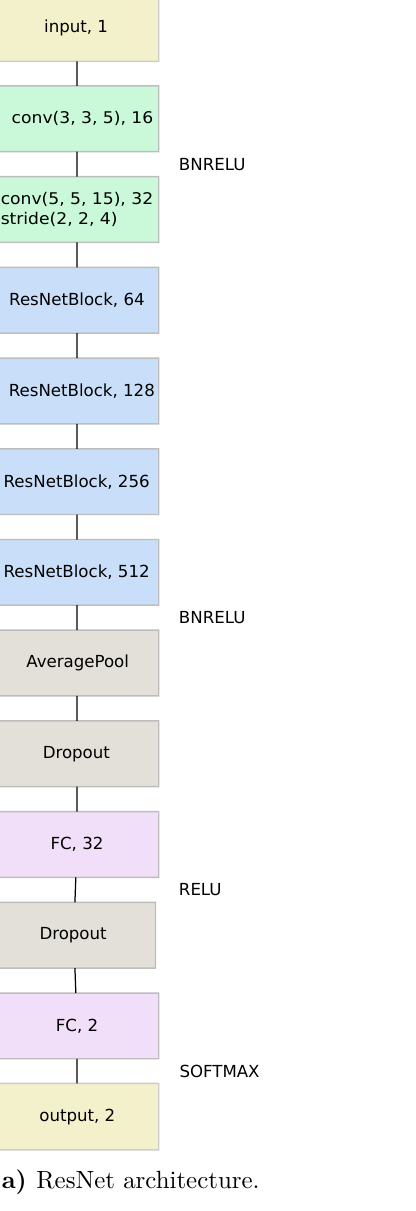
Figure 5 . (a) Summary of the neural network architecture used in this analysis, with (b) details of each ResNetBlock architecture. The following notation is used: conv(fx , fy , fz) , N represents a Convolutional 3D layer with filter size (fx , fy , fz) and N filters, with stride(sx , sy , sz) shown in the same cell if stride > 1 is applied. FC, N represents a fully connected layer with N output neurons. AveragePool is applied after the last ResNetBlock and Dropout with p = 0 . 5 is applied before each FC layer. Nonlinear activation throughout the network is ReLU, except for the final activation which is Softmax. BatchNorm normalization layer is applied before ReLU activation for all but the last ReLU